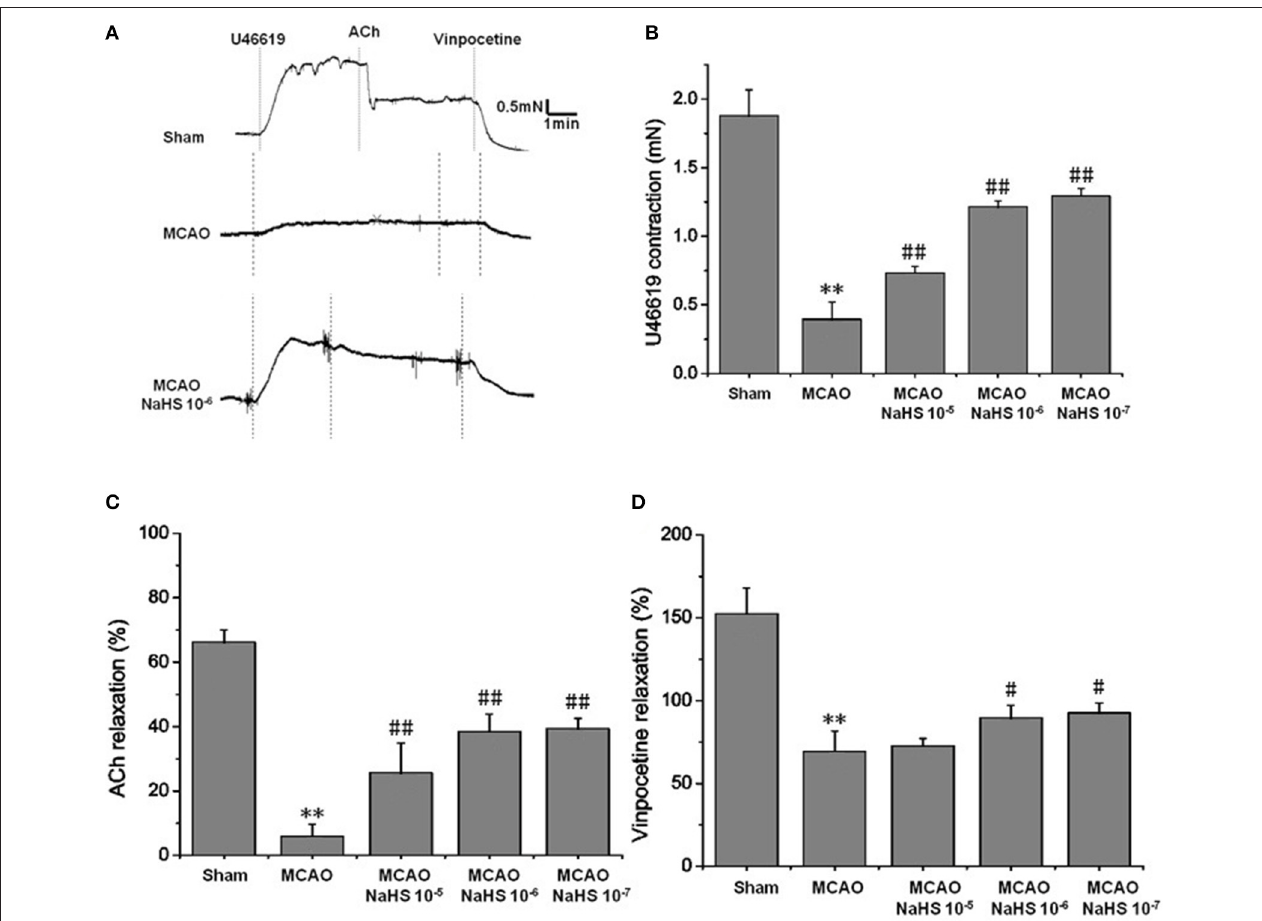
FIGURE 1 | Exogenous H 2 S attenuated cerebrovascular dysfunction induced by cerebral I/R in rats (mean ± SD, n = 8). (A) Original tracings of U46619-, ACh-, vinpocetine- and NaHS-induced responses of MCA derived from MCAO rats. (B) The effect of NaHS on U46619 meditated MCA contraction. (C) The effect of NaHS on ACh-meditated relaxation in MCA preconstricted with U46619. (D) The effect of NaHS on vinpocetine-meditated relaxation in MCA preconstricted with U46619. ** P < 0.01 vs. sham, ## P < 0.01 vs. MCAO, # P < 0.05 vs.